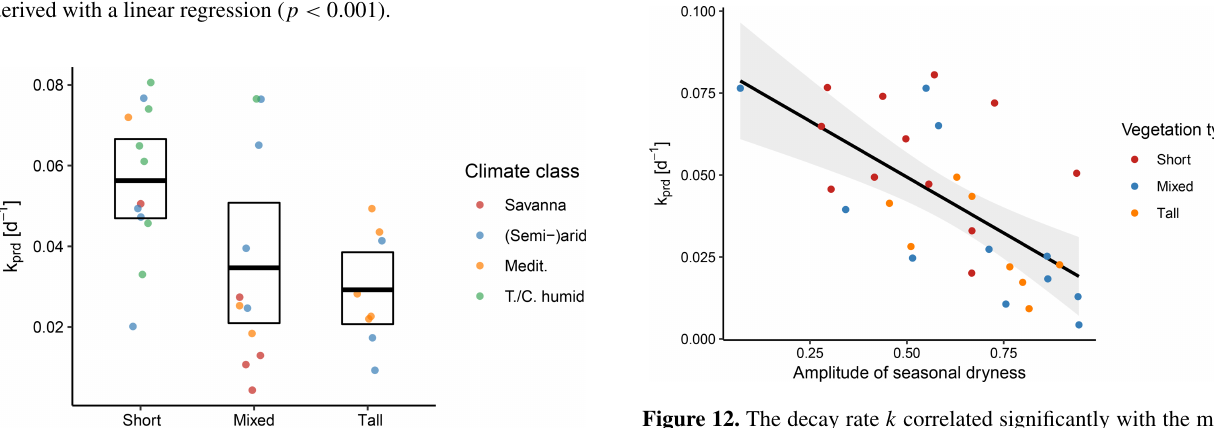
Figure 12. The decay rate k correlated significantly with the mean amplitude of seasonal dryness across sites ( p < 0 . 001, R 2 = 0 . 42). Among the vegetation types, this correlation was only significant for the mixed type ( p = 0 .